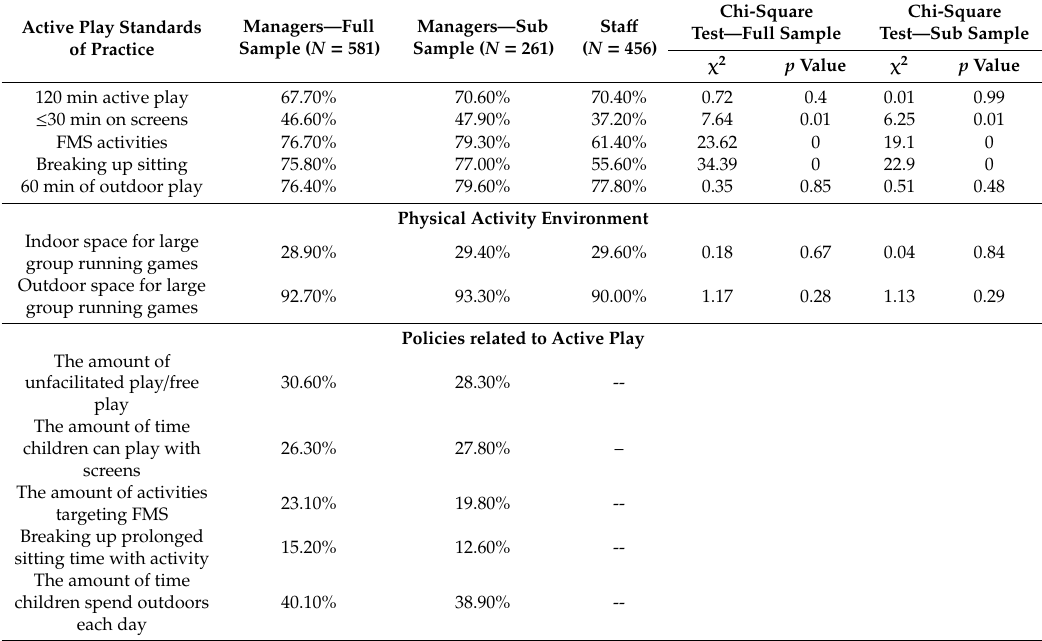
Table 2. Prevalence of reported physical activity policies, practices, and environment by childcare facility managers and sta ff .